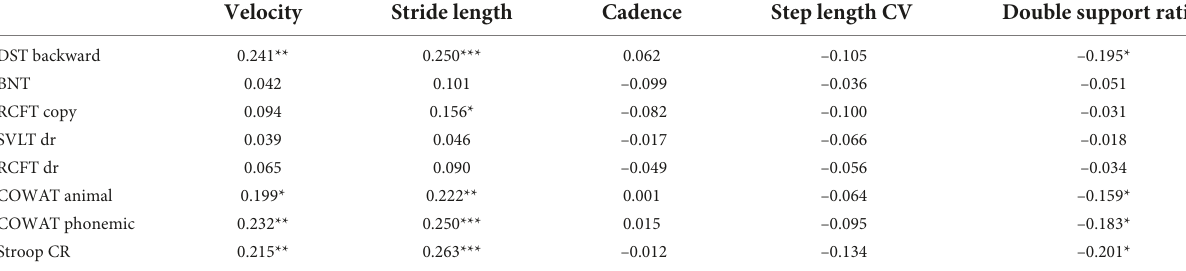
TABLE 4 Correlation between gait parameters and neuropsychological tests.